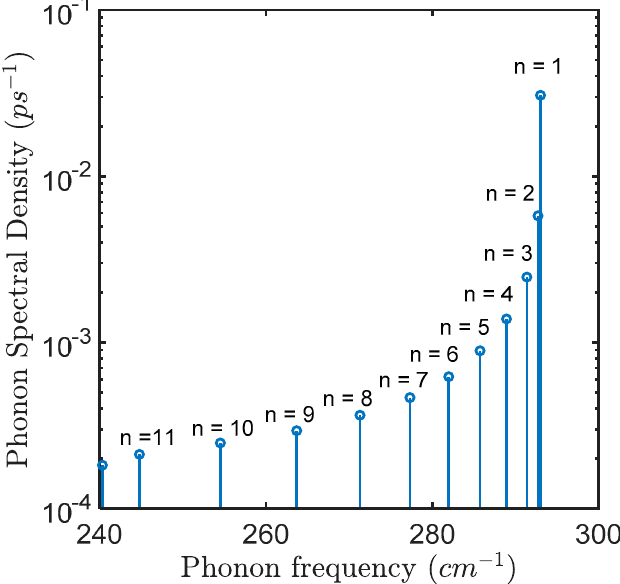
Figure 3. Confined LO mode phonon spectral density for a GaAs quantum dot of radius, R = 3.39 nm at T = 1 K. The discrete spectrum depicts the strength corresponding to each phonon mode contained in the 1st Brillouin zone (total 12 modes), with n = 1 having the highest magnitude and is located near the zone center. The n = 12 mode appears at 240.32 cm − 1